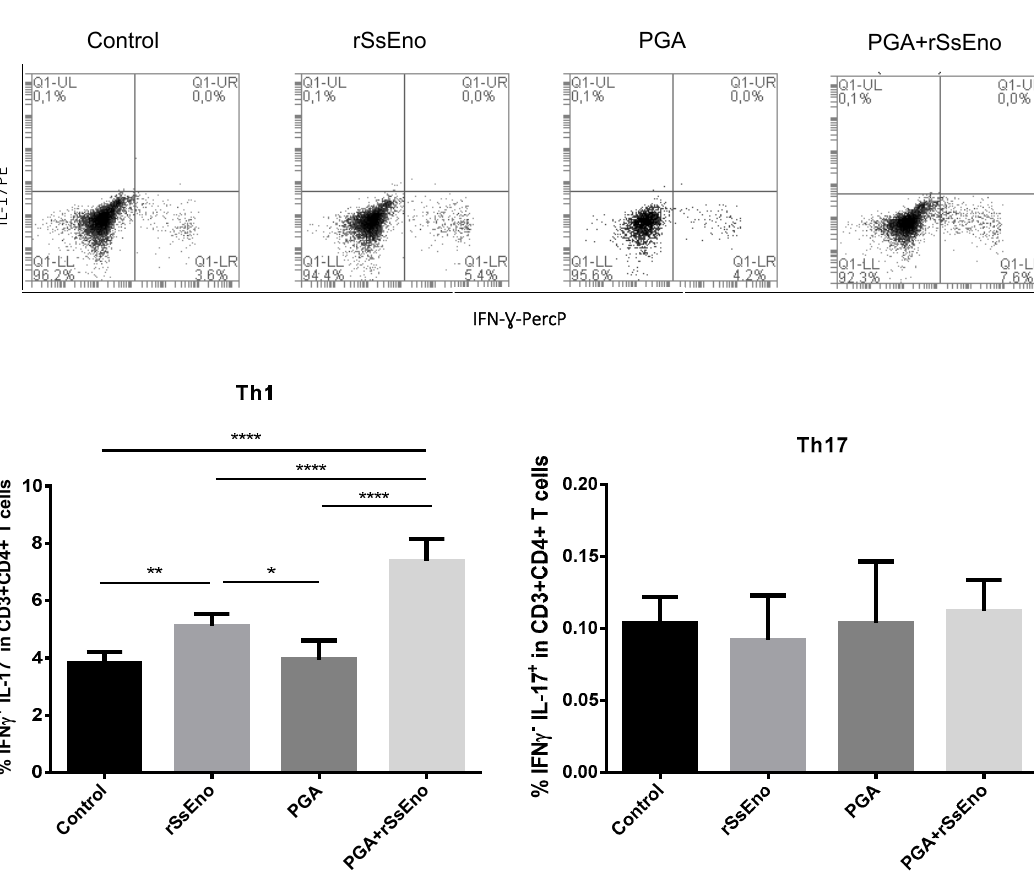
Figure 3. Response of Th1 (intracellular IFN- Ɣ +) and Th17 (intracellular IL-17A+) cells induced by immunization with the PGA+rSsEno. Balb/c mice were immunized (s.c.) twice with rSsEno, PGA, PGA+rSsEno, or PBS as negative control. Splenocytes of each animal were collected seven days after the second immunization and purified cells were stimulated in vitro with rSsEno and Brefeldin A. The frequency of Th1 and Th17 cells was detected using a BD Accuri C6 flow cytometer. Upper figure shows representative dot plots of Th1 and Th17 frequency collected from each group. * ( p < 0.05); ** ( p < 0.01); *** ( p < 0.001): **** ( p < 0.0001).